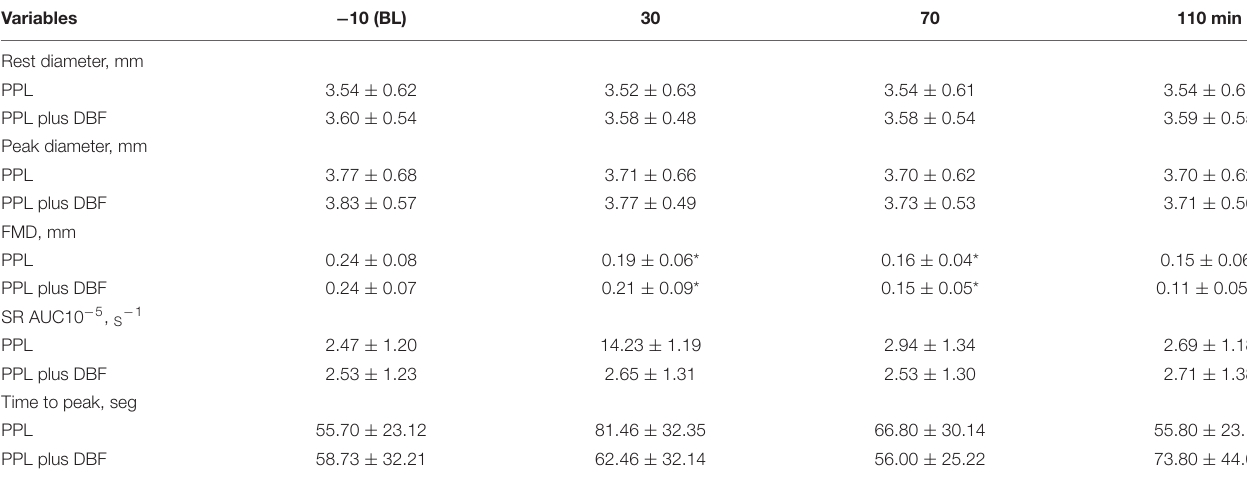
FIGURE 4 | Brachial artery flow-mediated dilation [FMD, (A) ] and delta FMD (B) to postprandial lipemia (PPL) and PPL plus disturbed blood flow (DBF) in healthy individuals. Data presented as mean ± standard deviation. * p < 0.05 vs. − 10 min (BL) in both sessions. † p < 0.05 differences between sessions in time point 110 min. Absolute delta was calculated as 110 min FMD–baseline FMD. TABLE 2 | Vascular variables of flow-mediated dilation during postprandial lipemia and postprandial lipemia plus disturbed blood flow.